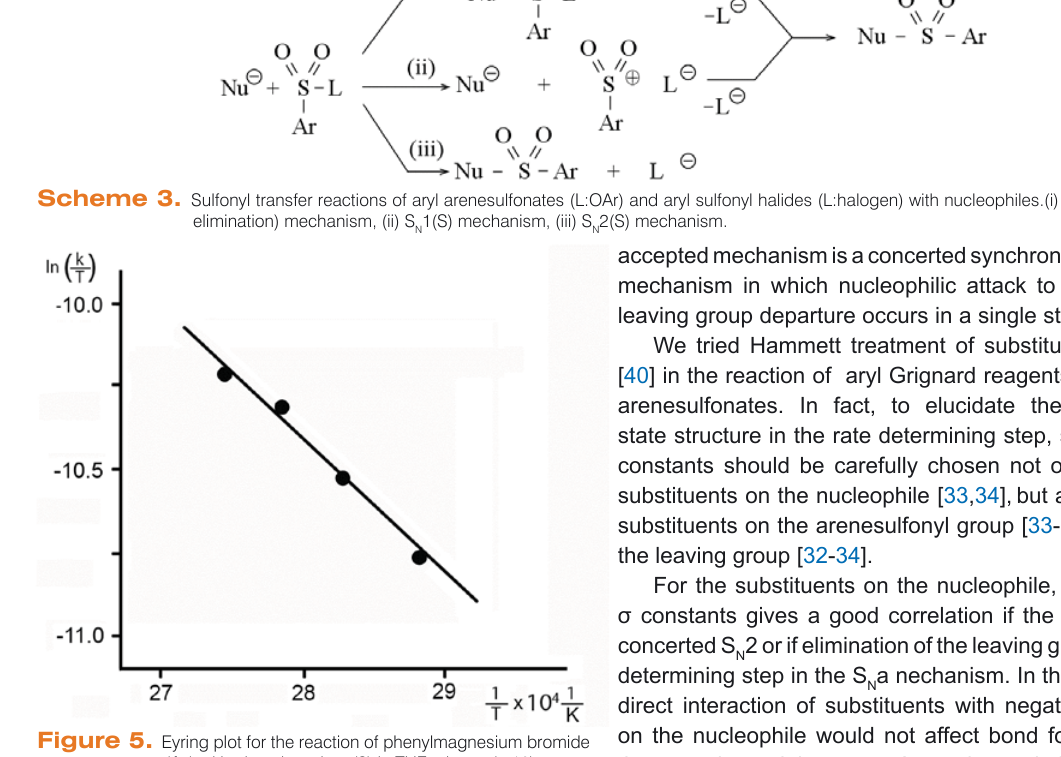
Figure 5. Eyring plot for the reaction of phenylmagnesium bromide ( 1a ) with phenyl tosylate ( 2 ) in THF:toluene (7:10).